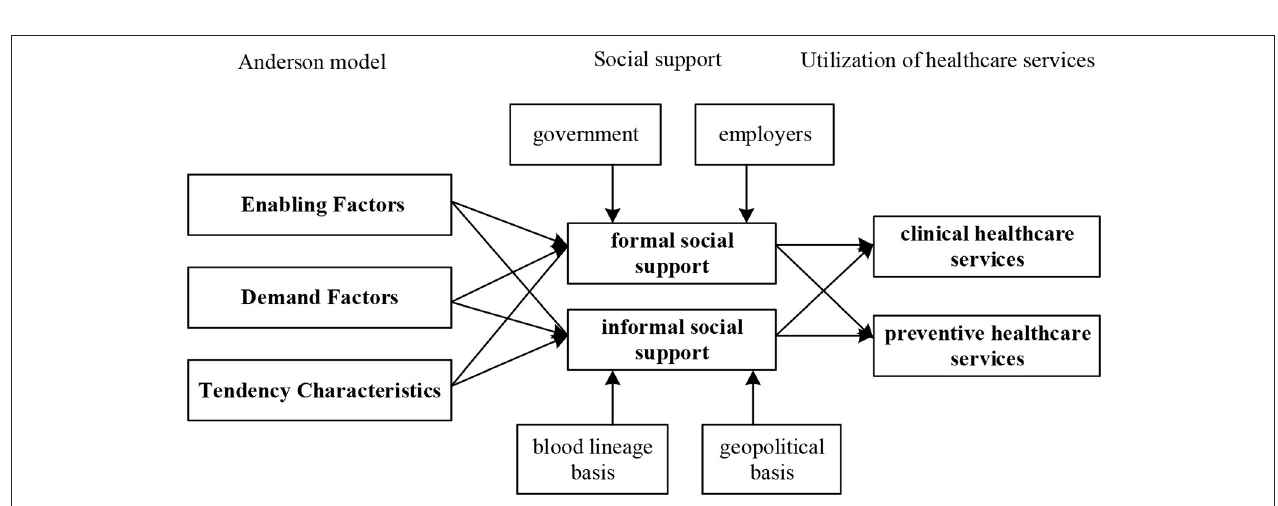
FIGURE 1 | Current status of social support research.